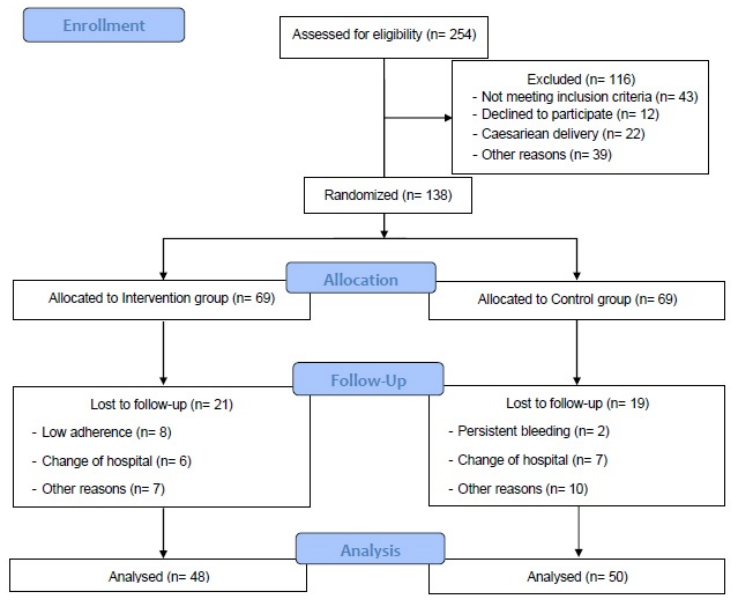
Figure 1. Study population flow chart.